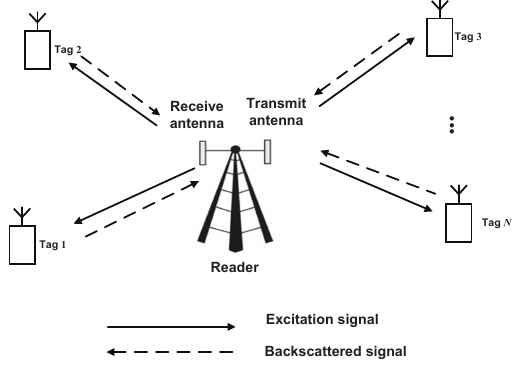
Figure 1. Multi-user backscatter communication